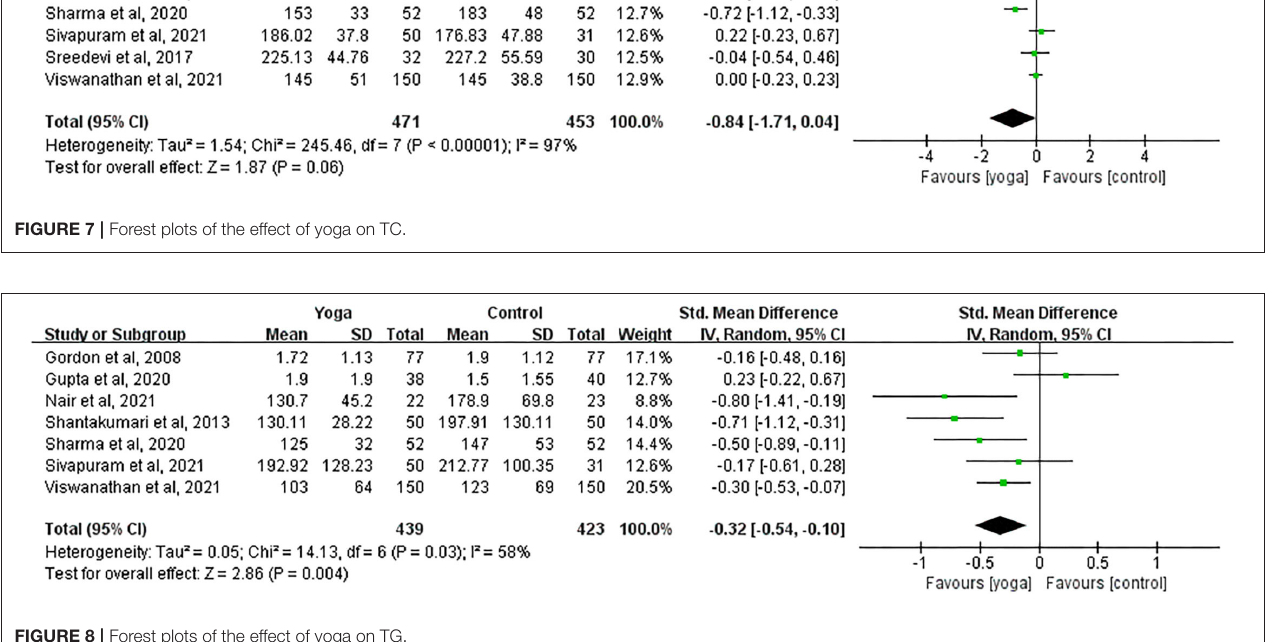
FIGURE 8 | Forest plots of the effect of yoga on TG.